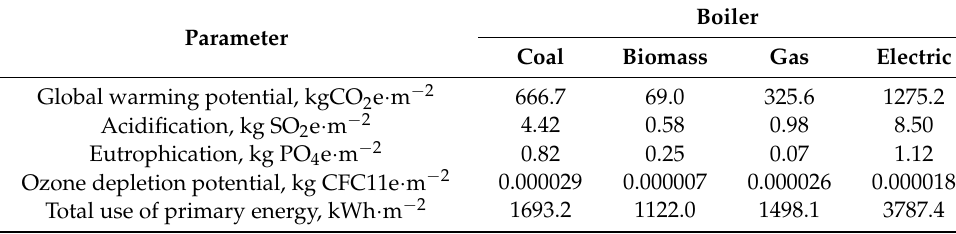
Table 2. Environmental impact factors for the operational stage over 25 years (BSTD case). Parameter